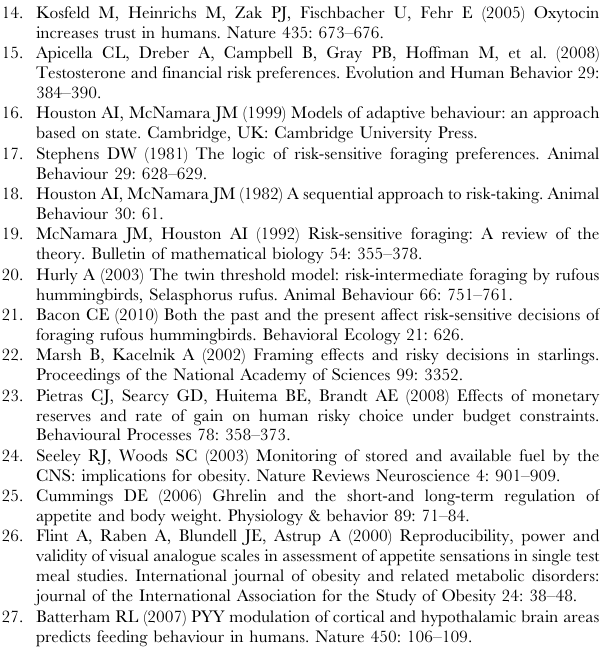
Table S2 List of 200 lotteries used for risk preference elicitation (all amounts in pounds; risk difference in pounds 2